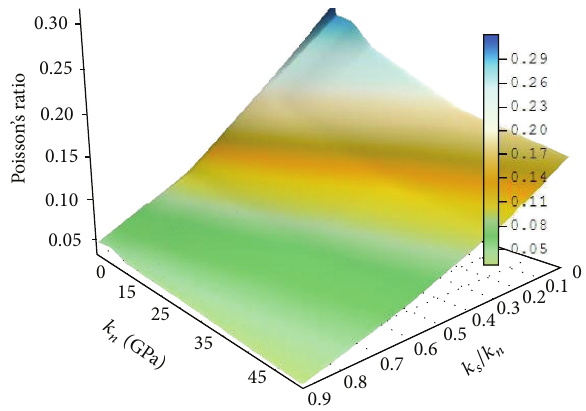
Figure 9: The changes in Poisson’s ratio with the microdeformation parameters.